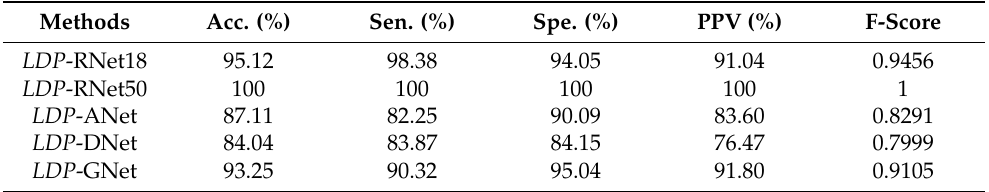
Table 3. Performance of various methods.